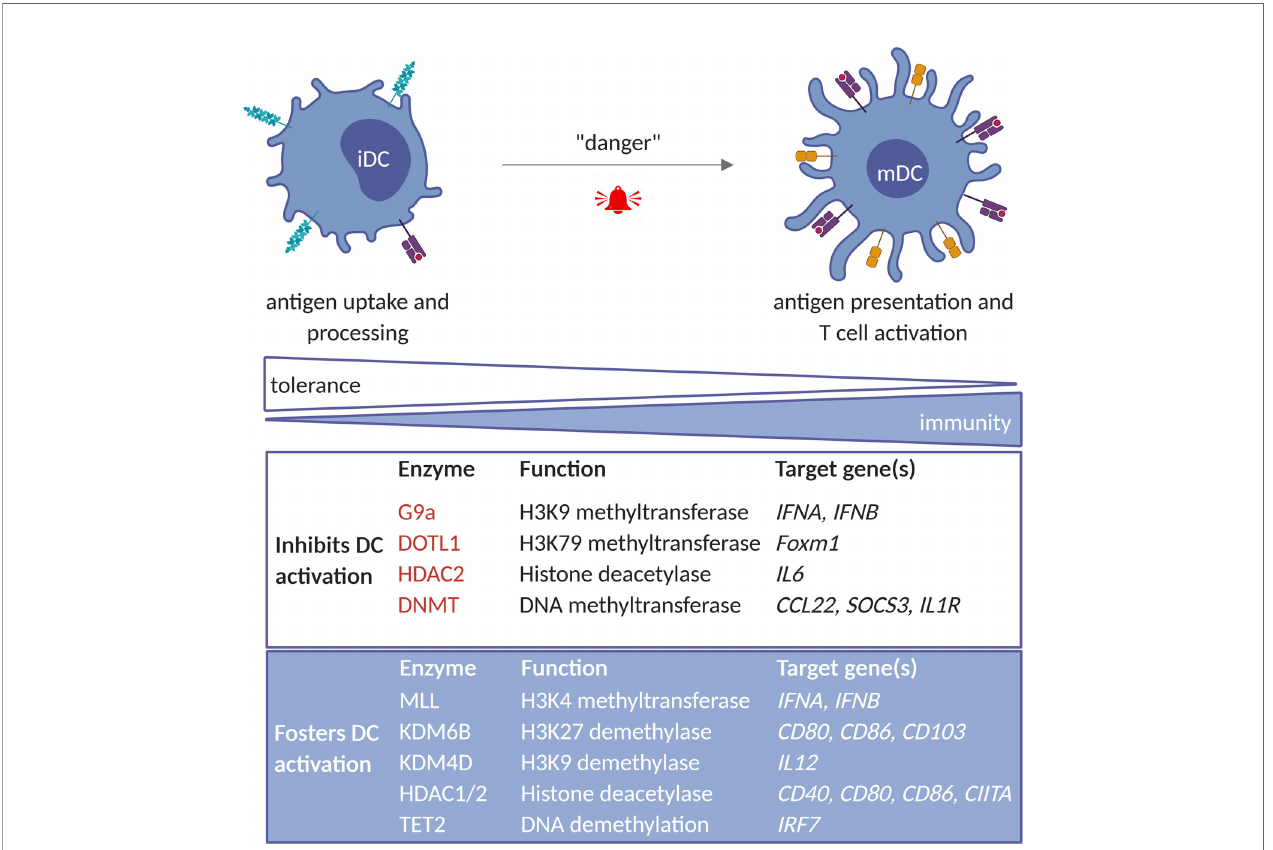
FIGURE 2 | Epigenetic factors that regulate TADC activity. Epigenetic enzymes that foster DC-activation include MLL complex (HMT); KDM6B and KDM4D (HDM); HDAC1 and 2 as well as TET2. Collectively these enzymes regulate the expression of genes involved in antigen presentation and stimulation of CTL-responses, such as CIITA, CD40, CD80, CD86, IL12 and IFNA/B . In contrast, enzymes such as the G9a (HMT), HDAC2, and the DNMT1, DNMT3A and DNMT3B rather inhibit DC- activity by acting on genes such as IL6, IFNA/B, CCL2, SOCS3 and IL1R . G9a, DOTL1, HDAC2 and DNMT represent potential targets to improve DC mediated anti- tumor immunity. iDC, immature dendritic cell; mDC, mature dendritic cell; HMT, histone methyltransferase; HDM, histone demethylases; HDAC, histone